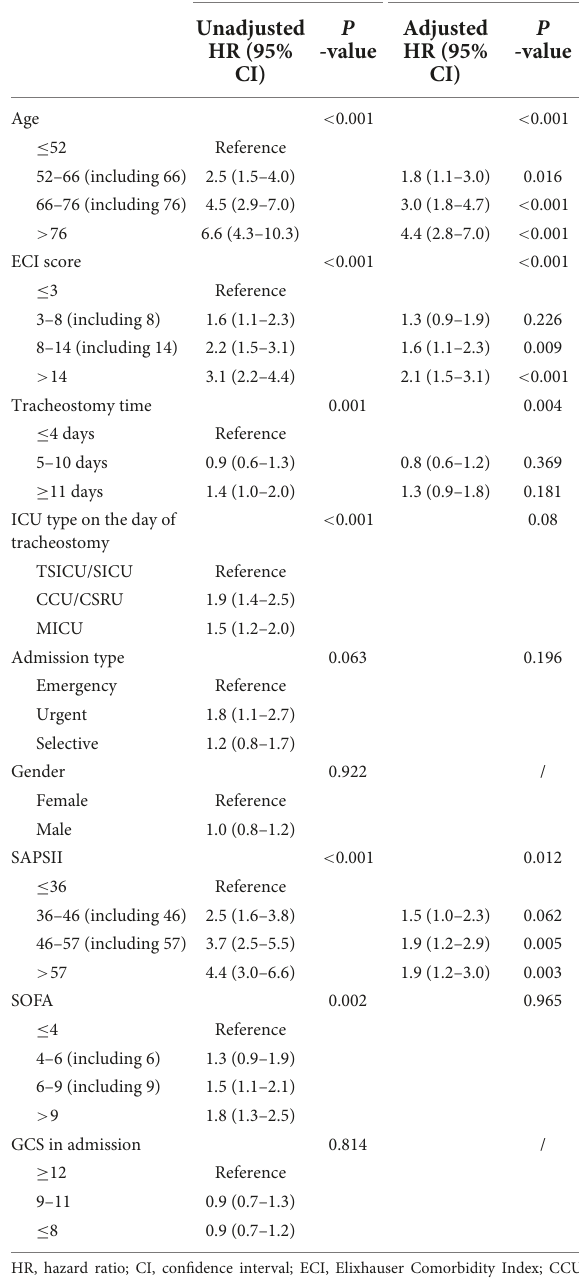
TABLE 1 Baseline in different tracheostomy timing.